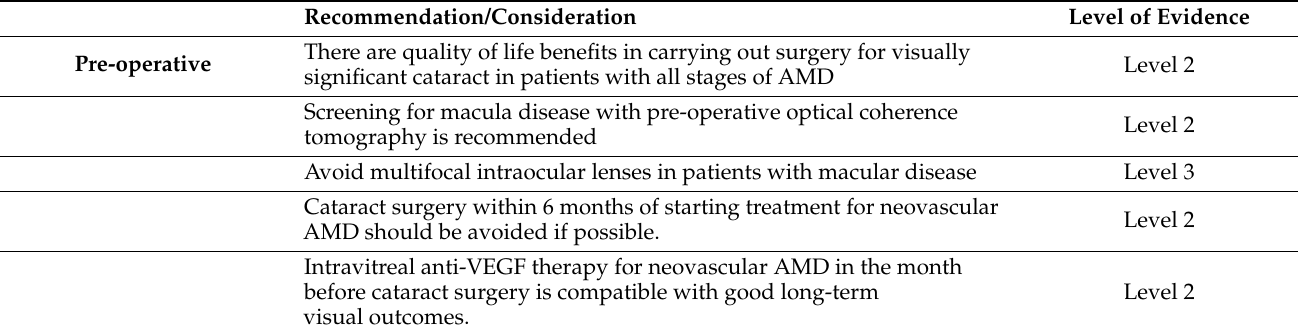
Table 1. Summary of factors to consider when carrying out cataract surgery in patients with age-related macular degeneration. Recommendation/Consideration